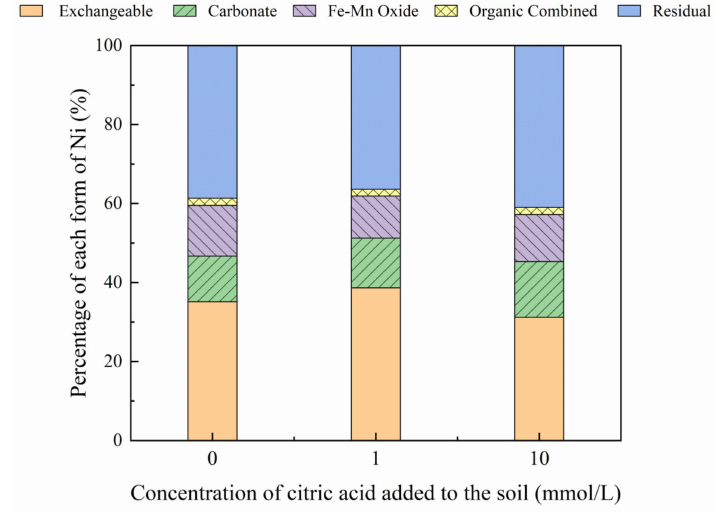
Figure 3. Distribution of different Ni forms in Ni-100 soil after the addition of citric acid (0, 1, 10 mmol/L).